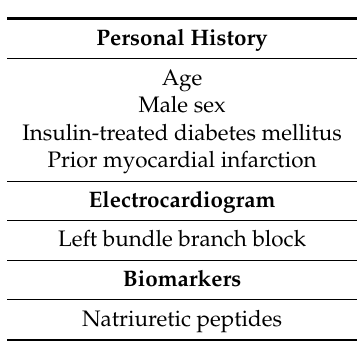
Table 2. Risk factors for SCD in